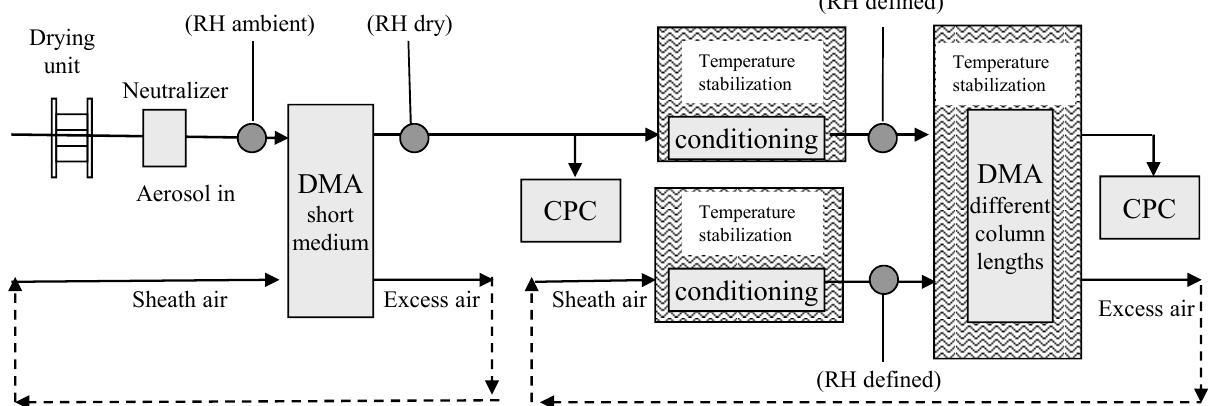
Fig. 1. Schematic picture of the custom-built H-TDMA systems used within this study. Systems showed varying technical details. The dotted lines show the possibility for a closed loop system realised by some of the used set ups. The sheath air of the second DMA can also be used for humidification of the aerosol sample air, which is not shown in the sketch, but realised for some of the used set ups.